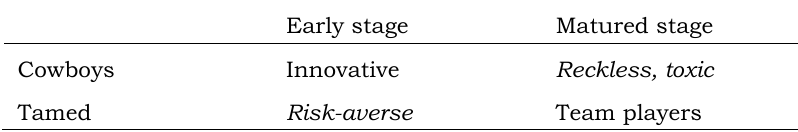
Table 1. Preferred/Non-preferred Characteristics of